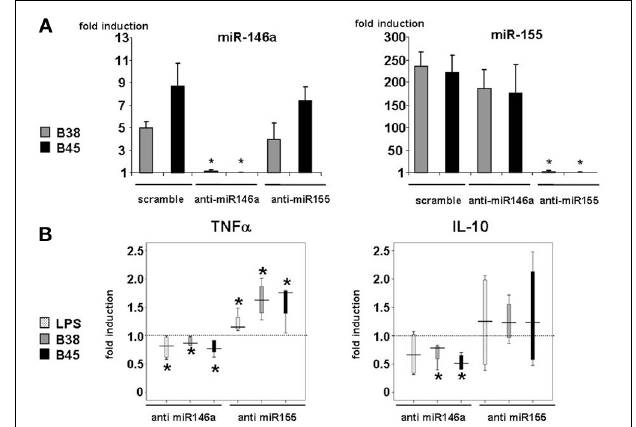
FIGURE 3 | Effect of miR-146a and miR-155 loss of function in H. pylori -induced miRNA levels and TNF α and IL-10 production. (A) Changes in miR-146a and mir-155 relative levels in DCs transfected with anti-miRNA oligonucleotides: DCs were transfected with 100nM of miRNA-antisense (anti-miR-146a or anti-miR-155) or scrambled oligonucleotides before being challenged with B38 or B45 H. pylori strains at MOI 1 for 48h. RTqPCR data are presented as the fold induction ratio (mean + standard deviation of triplicates) in activated DCs and are representative of one experiment out of 4.*if p < 0 . 05 compared to miRNA levels obtained on activated DCs treated with scrambled oligonucleotides. (B) TNF α and IL-10 production in activated DCs transfected by either anti-miR146a or anti-miR155 oligonucleotides: DCs were transfected as in (A) and activated with E. coli LPS (100ng/ml) or H. pylori B38 or B45 strains at MOI 1 for 48h. TNF α and IL-10 production was evaluated by flow cytometry. The horizontal bar across the box indicates the median and the capped bars indicate the minimum and maximum data values of fold induction ratio compared to scrambled oligonucleotide-treated cells for 4 independentexperimentscorresponding to 4 different donors (*if p < 0 .